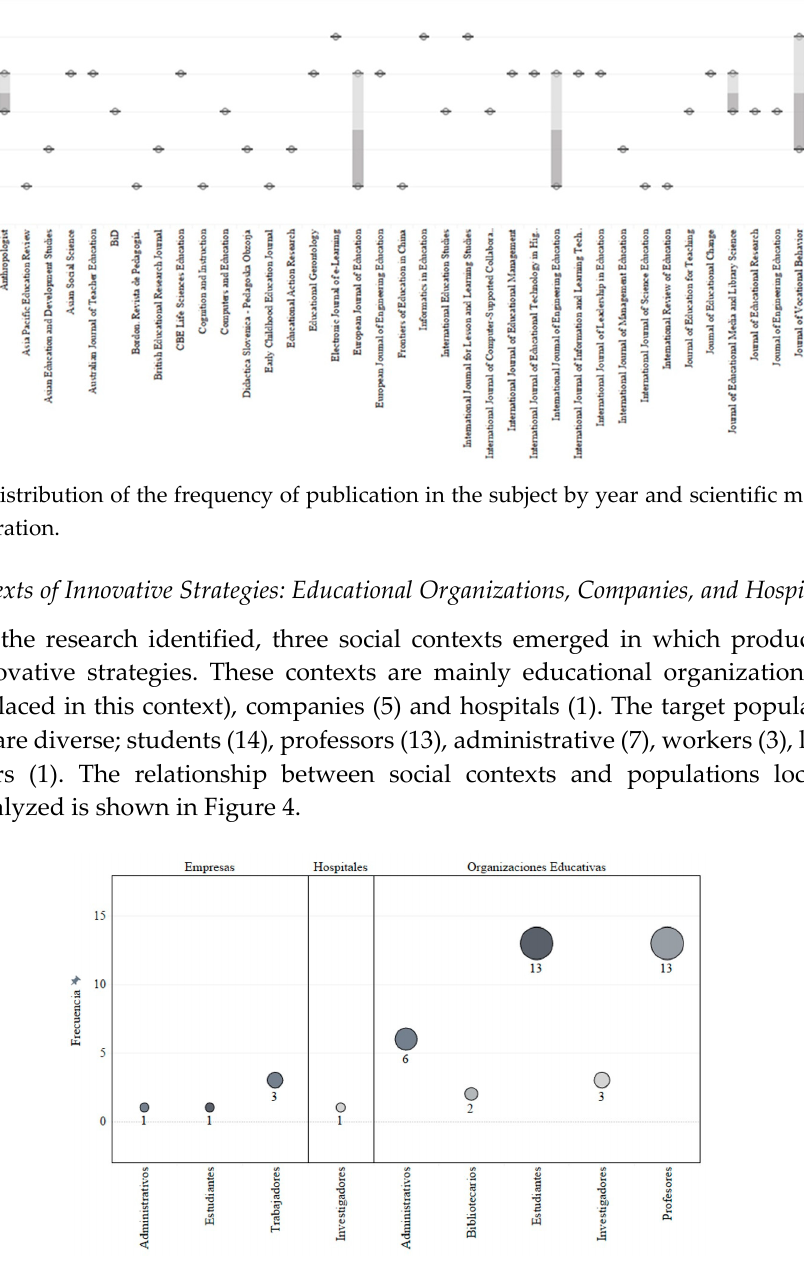
Figure 4. Social contexts and populations that have been addressed in the investigations of the subject. Own